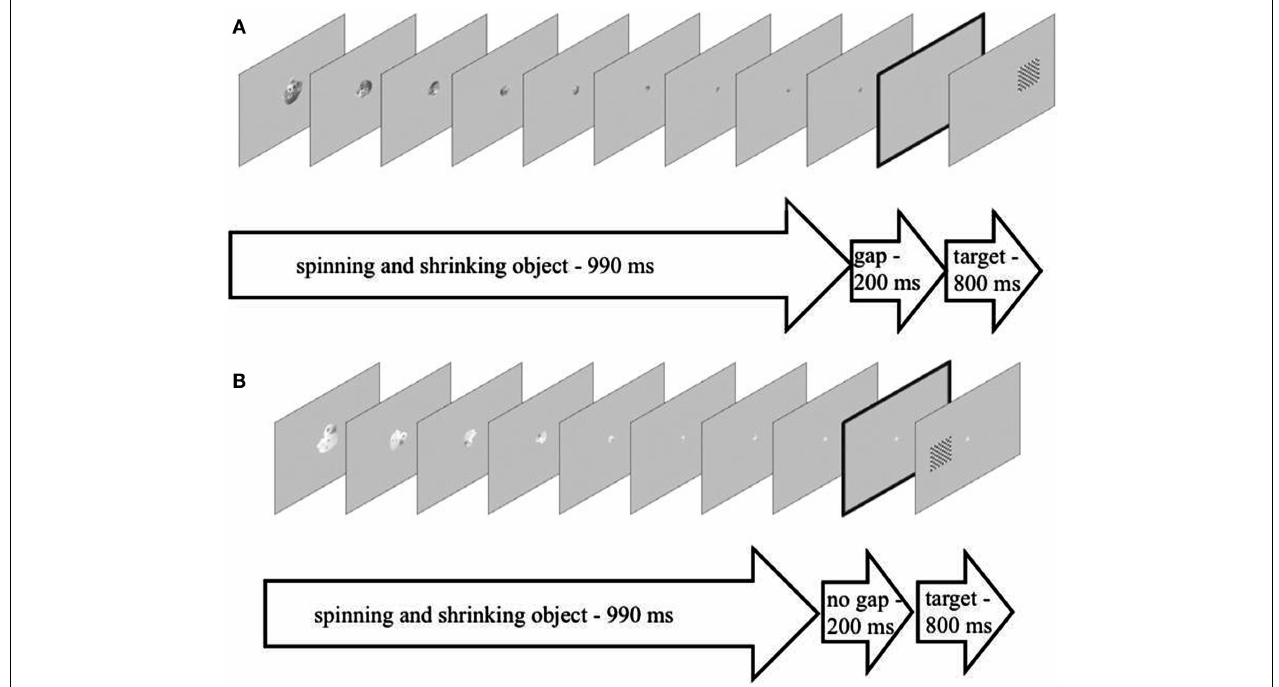
example of the setup of a trial depicting the experimental condition without a gap (presented for 200ms) between the spinning and shrinking objects (presented for 990ms, nine individual images presented for 110ms each) and the target checkerboard (presented for